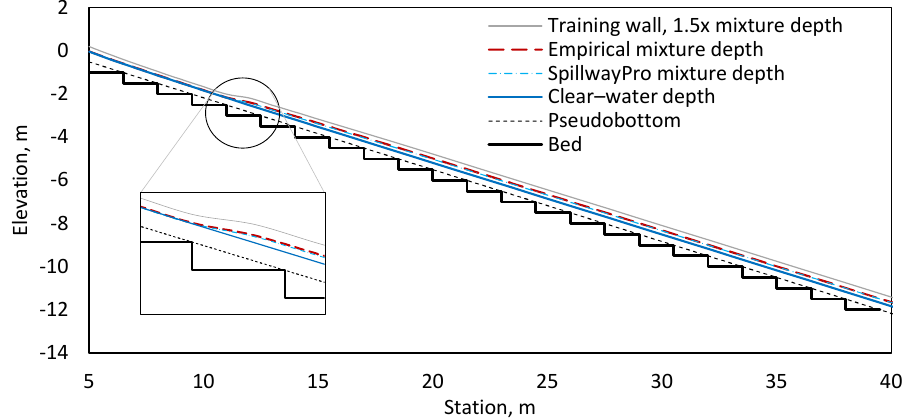
Figure 7. Example stepped chute water surface profile results.